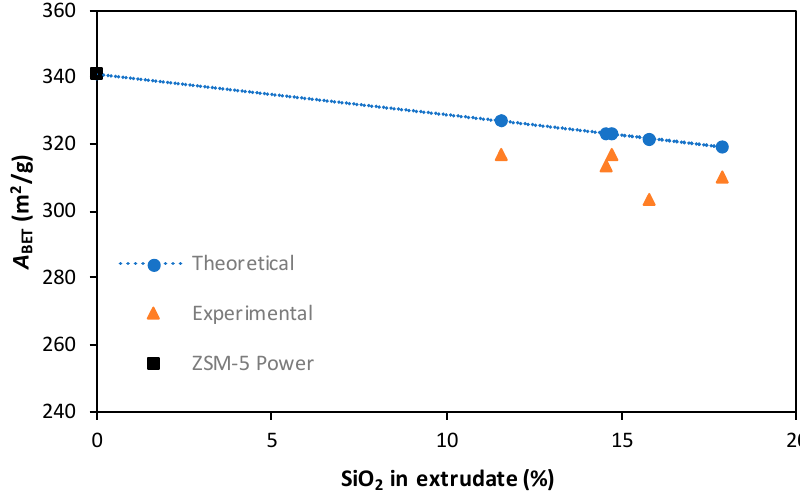
Figure 6. BET surface area as a function of the silica content in the extrudate after thermal treatment at 773 K. The experimental data are compared with the theoretical value considering the original BET surface areas from the ZSM-5 and the amount of SiO 2 employed.